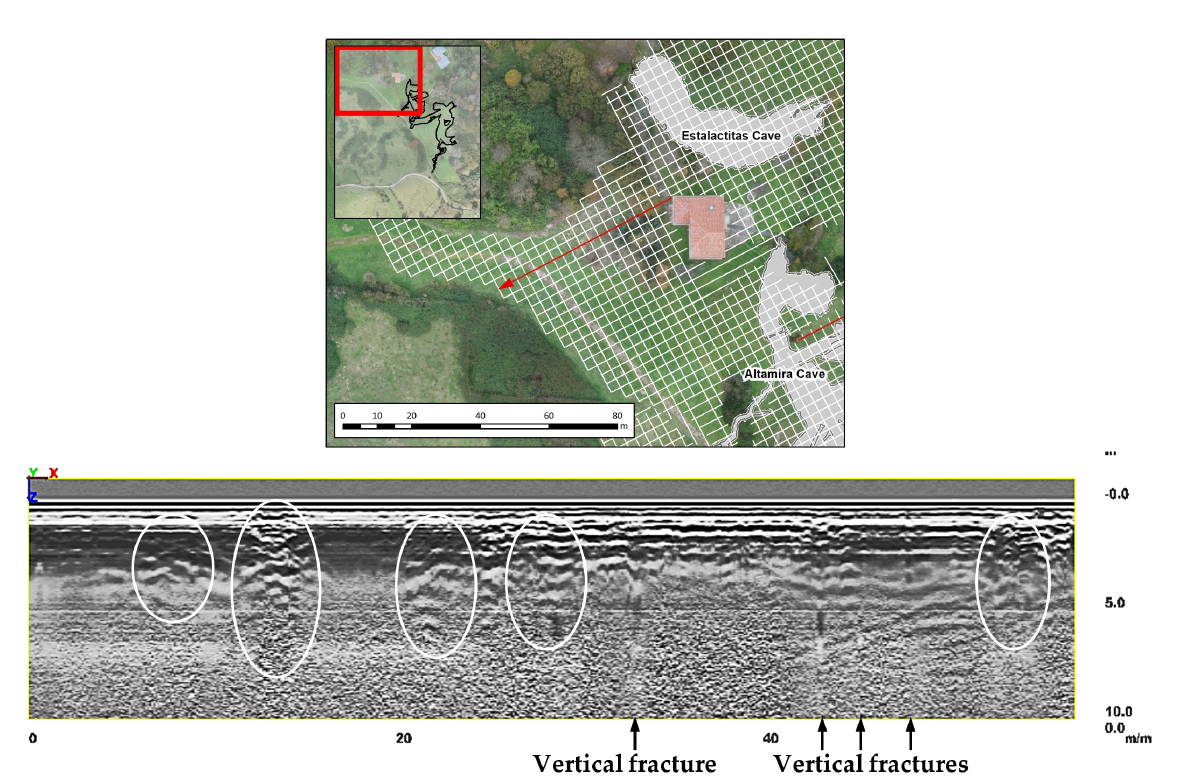
Figure 6. Radargram recorded with the 100 MHz antenna. Profile Z2-85 above shows discontinuities in the rock mass: several sinkholes (indicated by white ovals) and vertical fractures. This radargram also shows the attenuation of the electromagnetic wave in the last meters of depth.